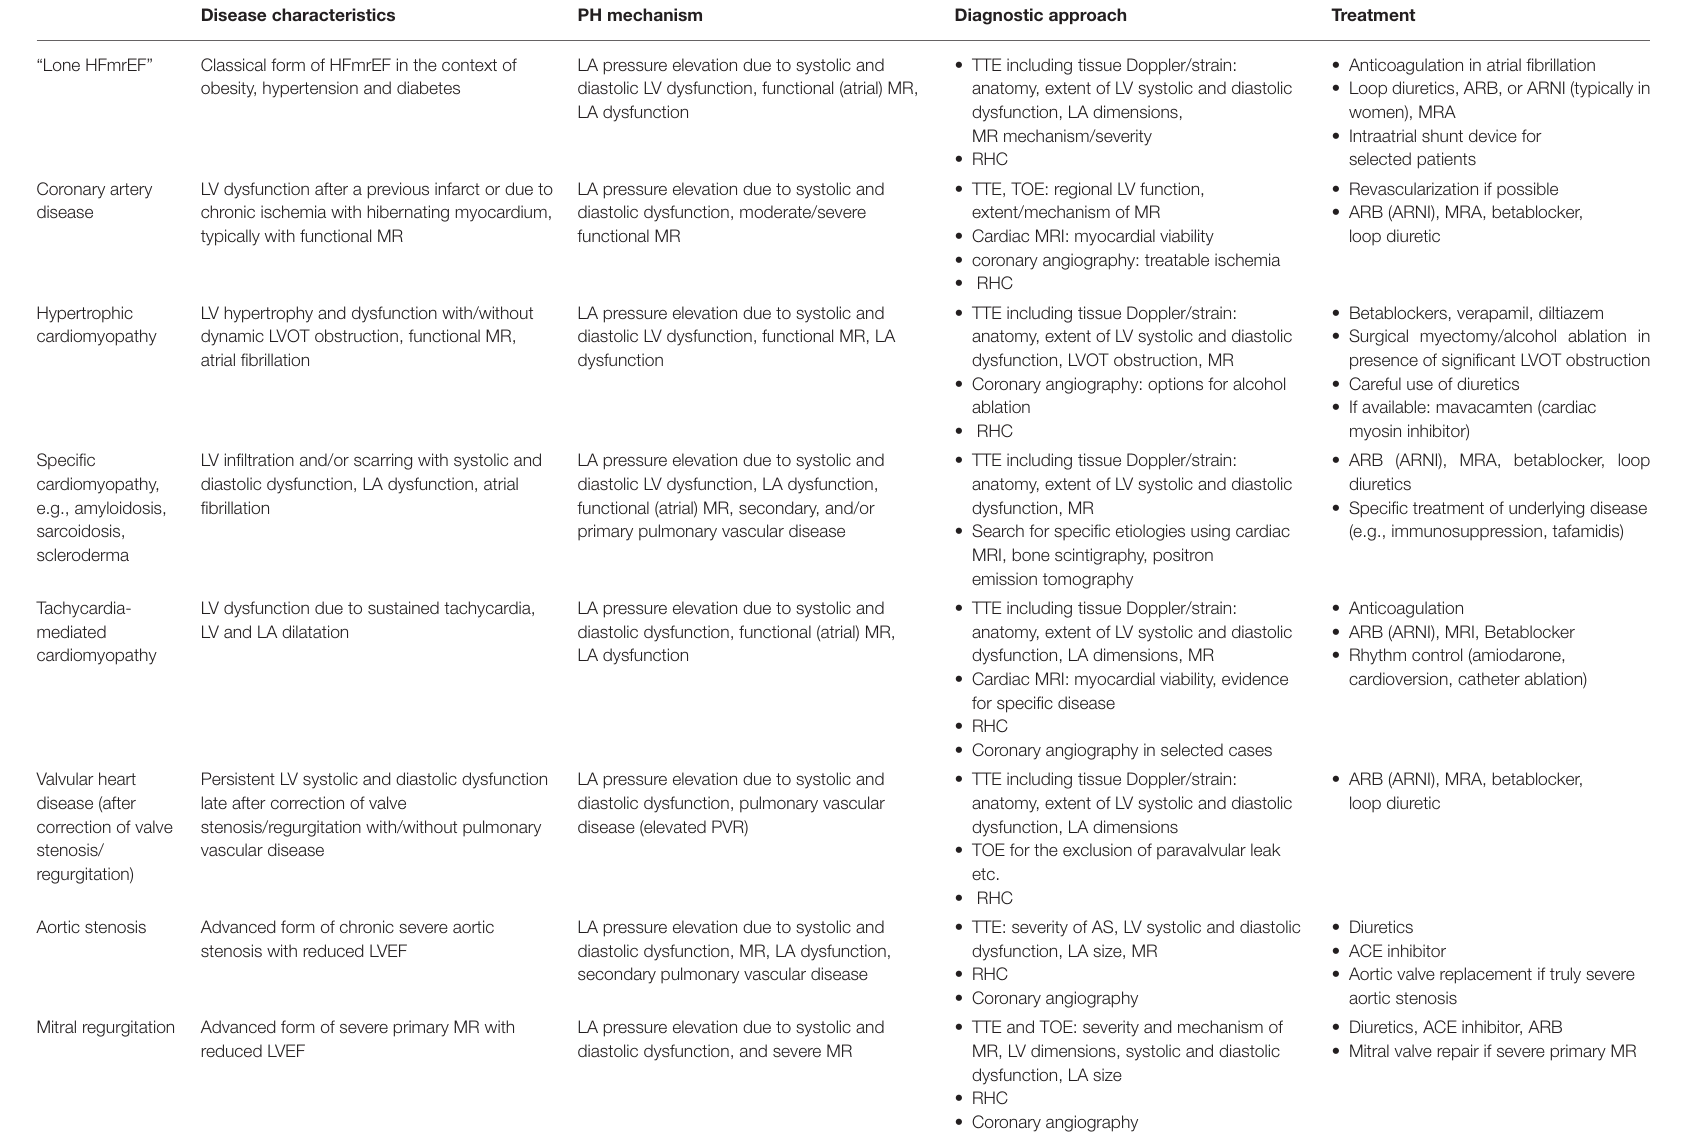
TABLE 2 | Pulmonary hypertension (PH) in Heart Failure with mid-range left ventricular Ejection Fraction (HFmrEF): different disease entities and mechanisms (please also see